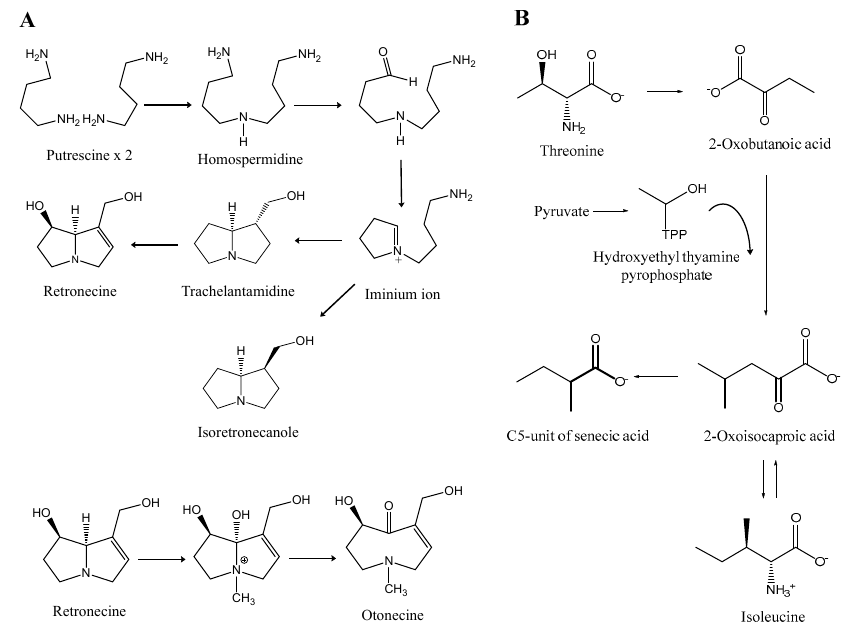
Figure 7. Biosynthesis of necines ( A ) and of senecic acid ( B ). Adapted from [1,16,20,24].